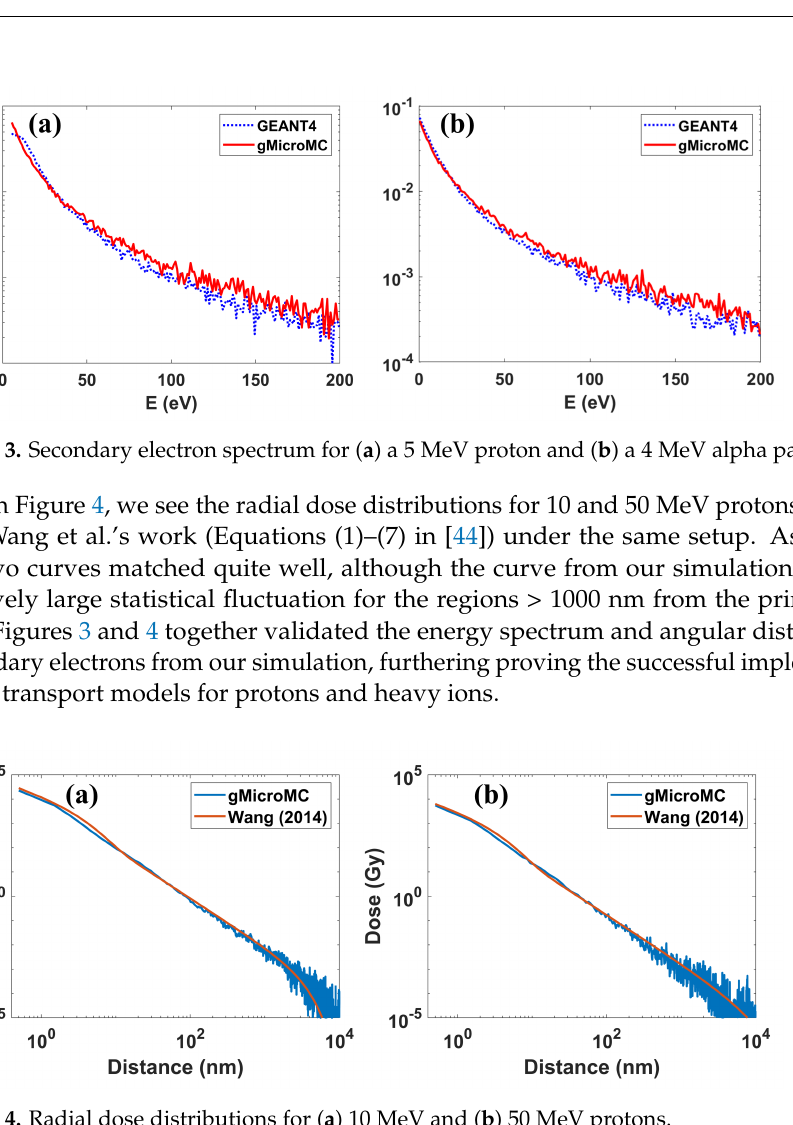
Figure 4. Radial dose distributions for ( a ) 10 MeV and ( b ) 50 MeV